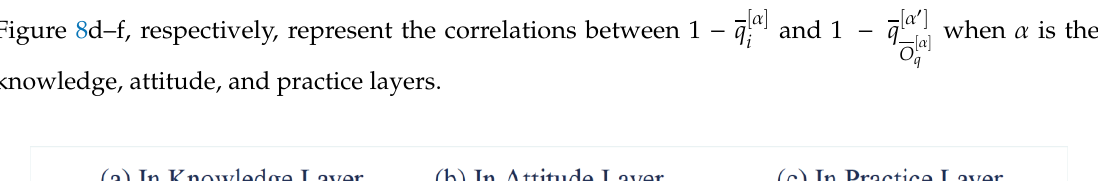
[ α ] [ α (cid:48) ] and 1 − q when α is the [ α ] i O q